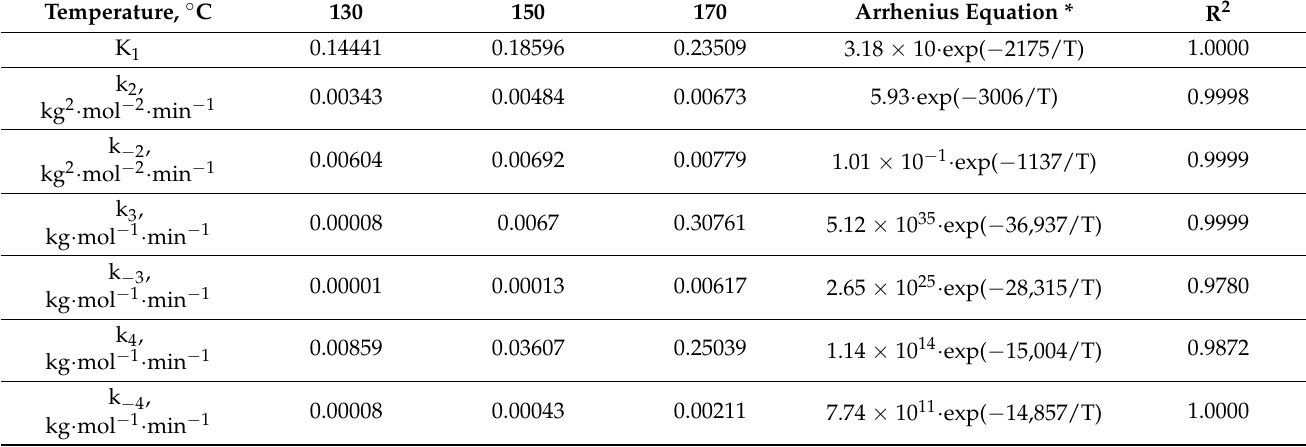
Table 2. Numerical values of the kinetic model